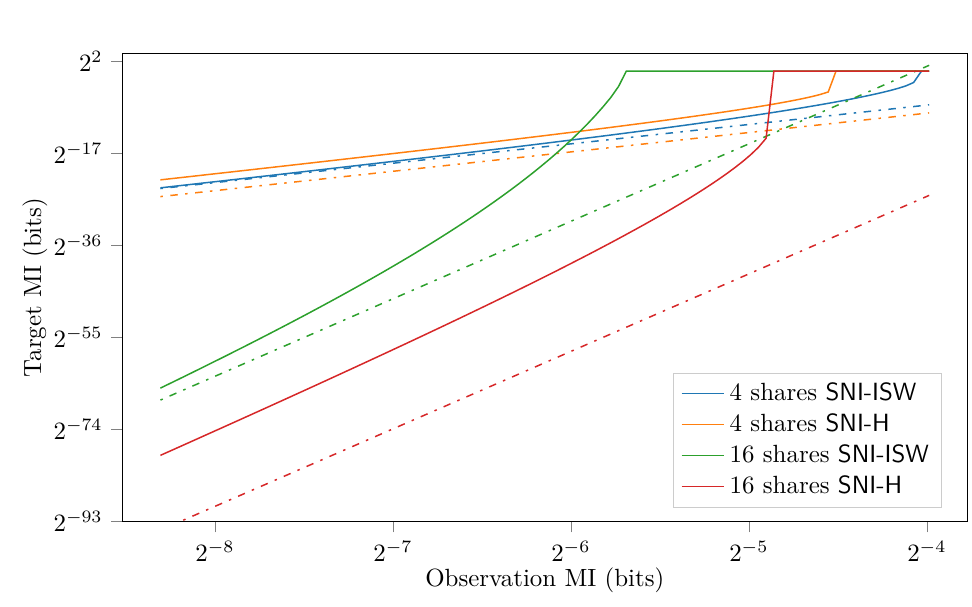
Figure 3: Target MI as a function of observation MI, for the SNI-ISW multiplication gadget [ISW03] and the SNI-H multiplication gadget [BCPZ16]. The continuous line is the bound on the target MI that can be extracted by the BP algorithm and the dashed line is a lower bound for the target MI computed assuming that only the leakages on input shares are exploited. The results for the NI multiplication gadget of Belaid et al. [BBP + 16] are identical to the SNI-ISW